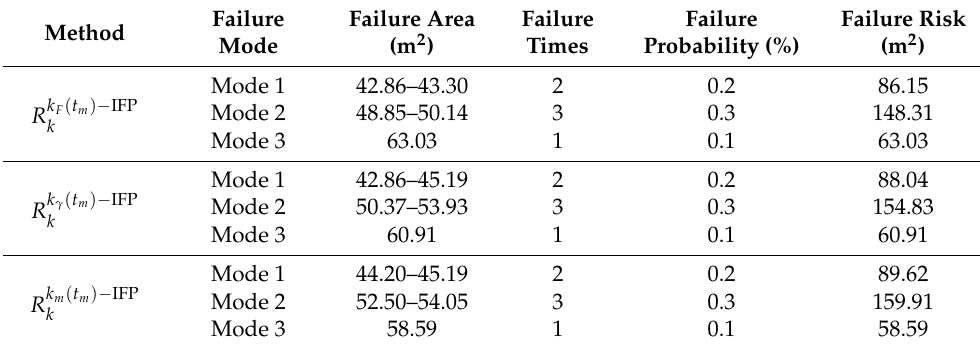
Figure 7. Histogram of homogeneous slope failure area. Table 3. Statistics of homogeneous slope failure modes.